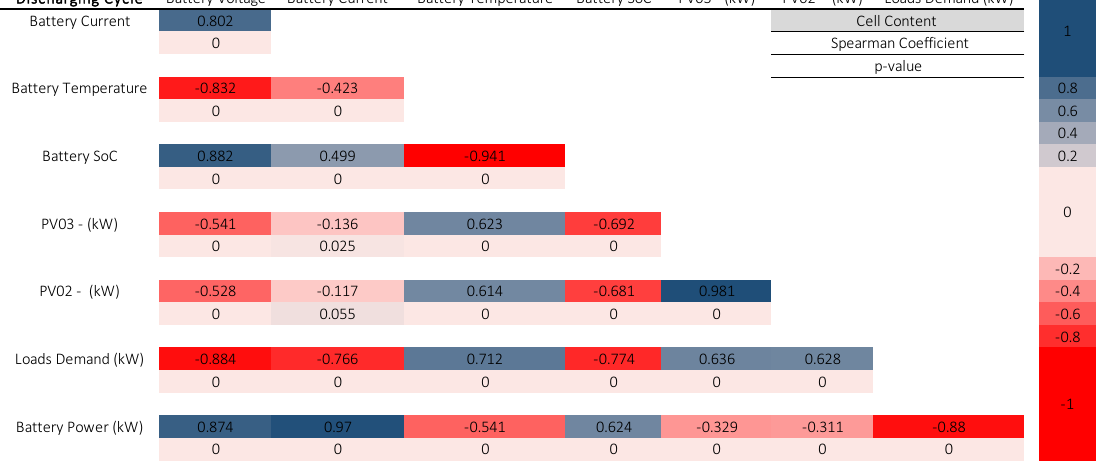
Figure 16. Spearman correlation matrix in discharging cycle of storage system.